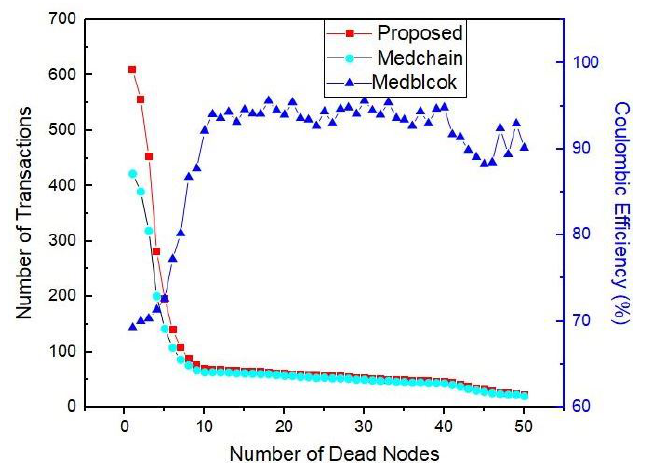
Figure 10. Number of dead nodes versus number of rounds for our proposed framework and benchmark models